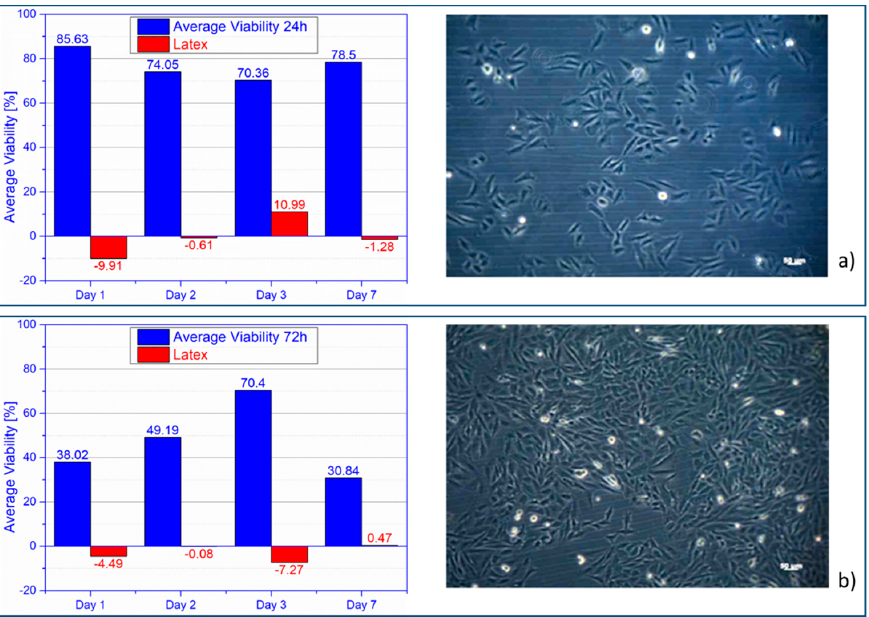
Figure 10. Average cell viability alloy vs. latex (left) and osteoblasts (right): ( a ) 24 h and ( b ) 72 h extract.